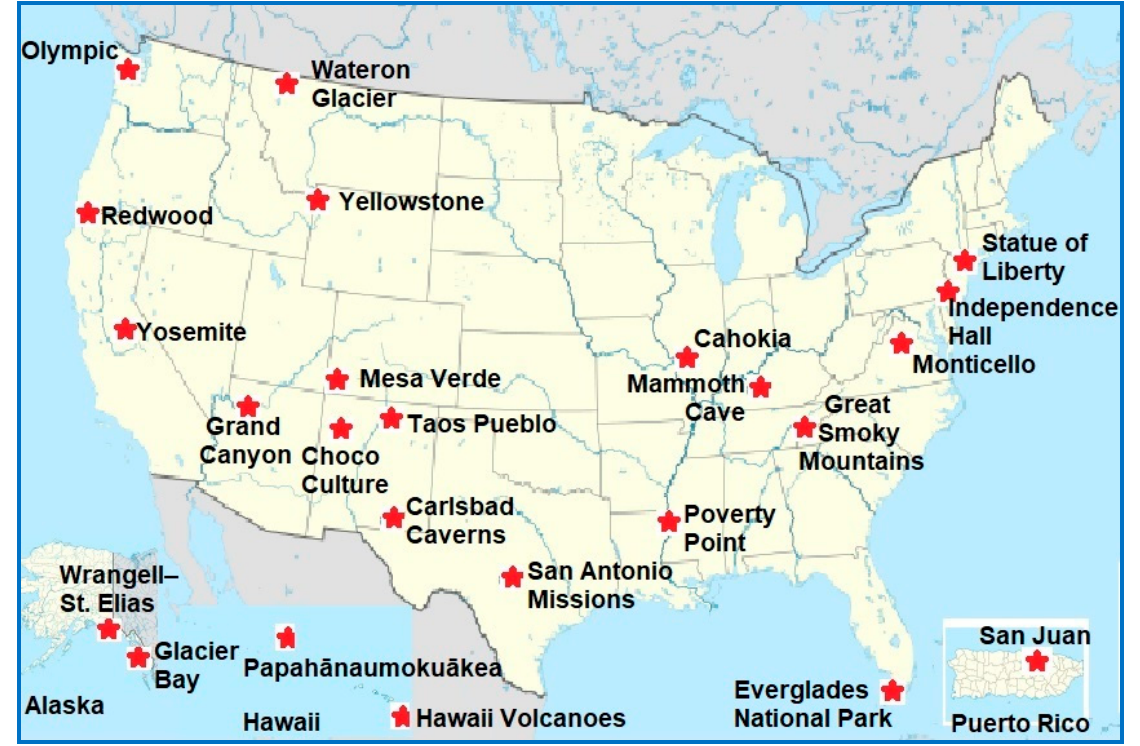
Figure 12. World Heritage sites in the United States ( https://whc.unesco.org/en/list/ ) (accessed on 19 January 2022).